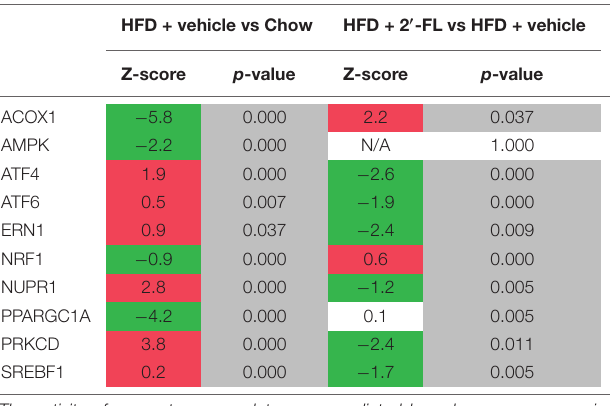
TABLE 3 | Upstream regulator analysis of factors controlling metabolic homeostasis in the